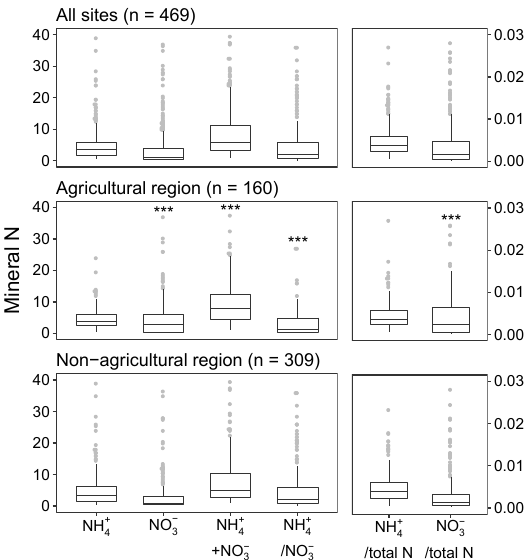
Figure 2. Mineral N contents (mgNkg − 1 ) and fractions of total N in soil. The bottom, middle, and top of each box represents the 25th, 50th (median), and 75th percentiles, respectively. The points above the whiskers are extreme values. Means between main agricultural and non-agricultural regions of Australia are significantly different at P -value < 0 . 001 (***), indicated by the ANOVA on the log of the